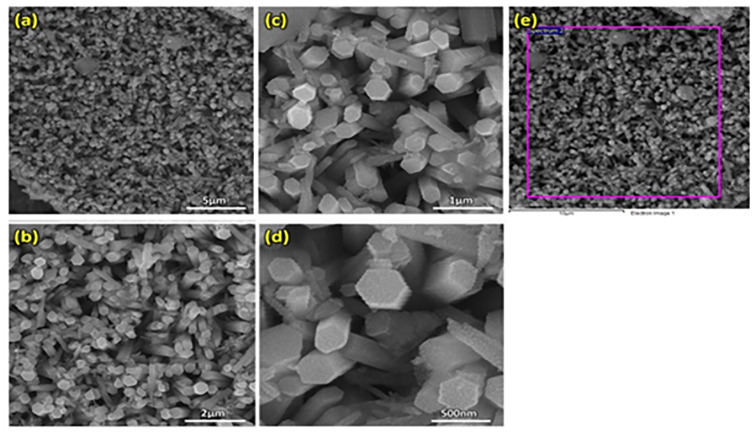
FE-SEM images of ZnO nanorods at a resolution of (a) 10KX, (b) 25KX, (c) 50KX, (d) 100KX, and (e) EDS spectra of ZnO nanorods.